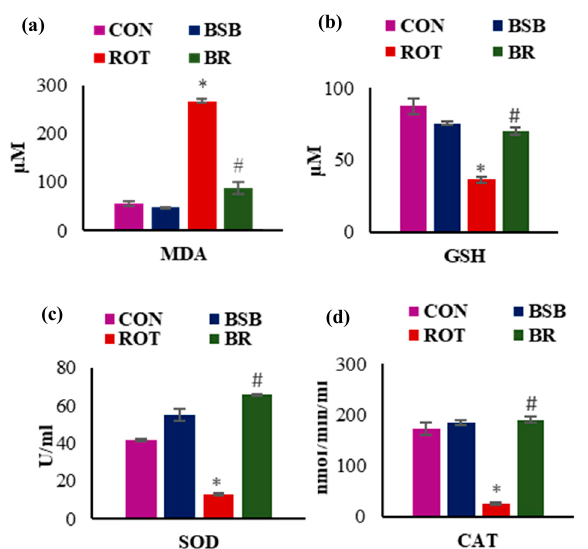
Figure 3. Change in the levels of MDA ( a ), GSH ( b ), SOD ( c ) and CAT ( d ) in the mid brain following ROT administration. ROT injected rats showed a significant increase in the MDA level and reduction in the GSH level compared to the vehicle treated control (CON) rats. Treatment with BSB to the ROT injected rats significantly decreased MDA, and increased GSH content. Furthermore, ROT injections also cause significant reduction in the activity of SOD and CAT when compared to the vehicle treated control rats. BSB treatment to ROT injected rats significantly increased the activity of SOD and CAT as compared to the ROT injected rats. The values are expressed as the mean ± SEM (n = 6–8). * p < 0.05 CON vs ROT; # p < 0.05 ROT vs. BR (One-way ANOVA followed by Tukey’s test).